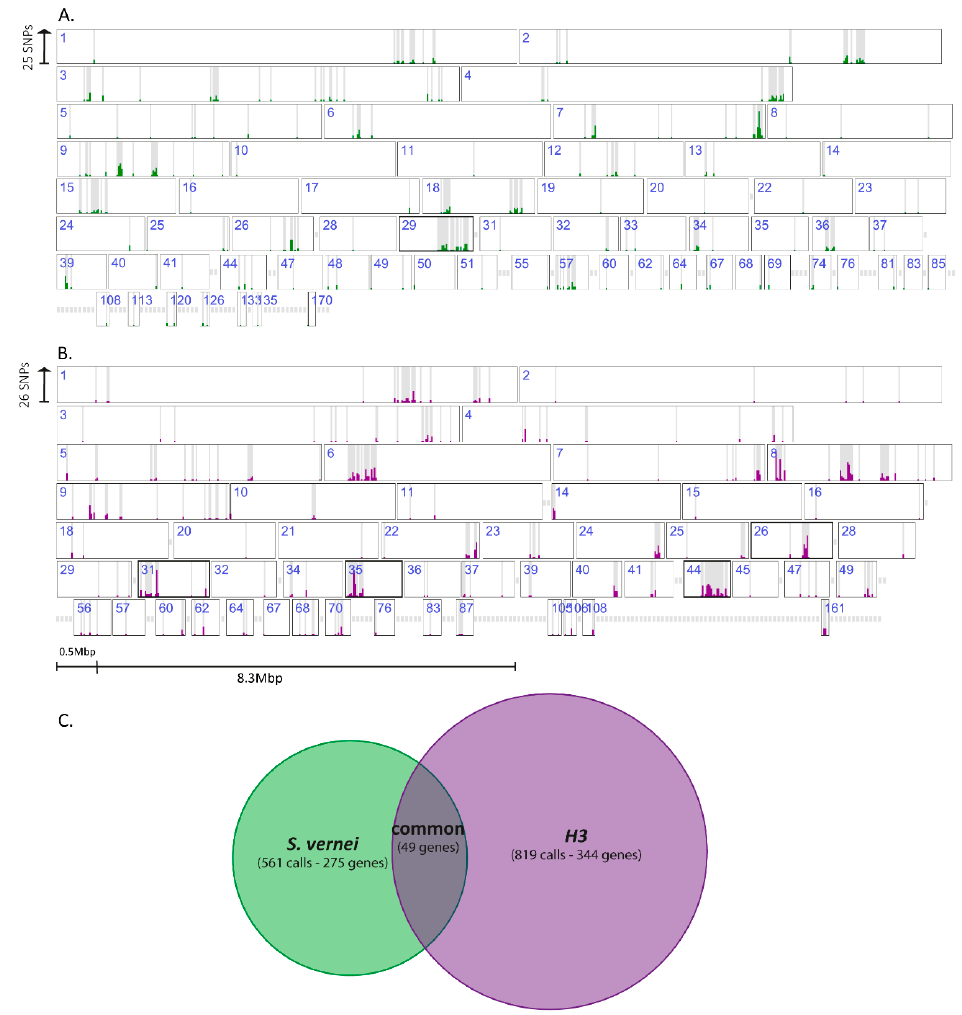
Figure 3. Distribution of variant calls (with high and moderate impact) identified in the ReSeq analysis in the ( A ) S. vernei - and ( B ) H3 -selected G. pallida populations. The height of the bar (green—calls associated with S. vernei -selected, purple—calls associated with H3 -selected populations) is relative to the maximum distribution of the identified single nucleotide polymorphisms (SNPs) in a specific region (( A ) max distribution is 25 SNPs and ( B ) max distribution is 26 SNPs). Each box represents each sca ff old of the G. pallida genome assembly [41]. Sca ff olds with no identified filtered variant calls are not presented. Sca ff olds with highlighted outline are potential genomic islands. ( C ) Venn diagram of the number of filtered calls and genes selected in the two biological